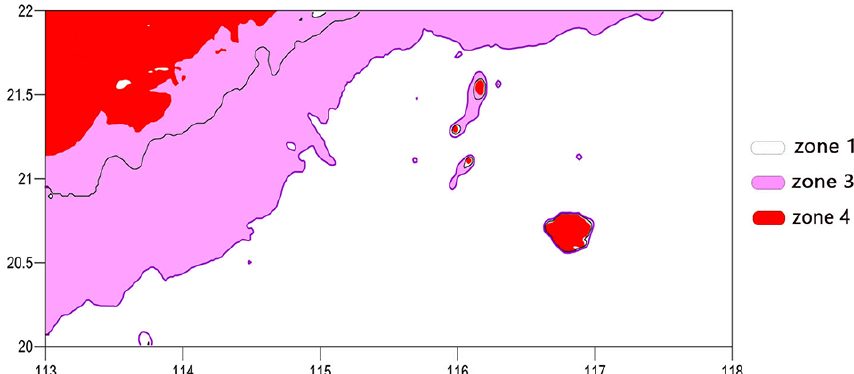
Figure 7. Zone map for internal waves’ transformation over the South China Sea shelf with an initial amplitude of 50m and a depth of the mixed layer of